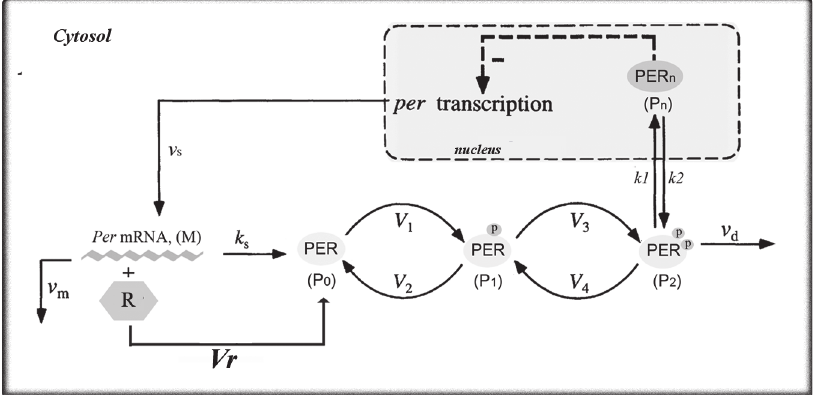
Figure 1. Scheme of the ‘ master ’ model proposed in the present work. The model is based on a Goodwin oscillator in which the temporal variation of the concentrations of mRNA ( M ) and the various forms of clock protein, cytosolic ( P 0 , P 1 , P 2 ) or nuclear ( P n ), are governed by the system of kinetics equations 1 – 5. The associated parameters with their specific values are indicated in S1 Table in S1 File. This scheme is similar to the one presented in [